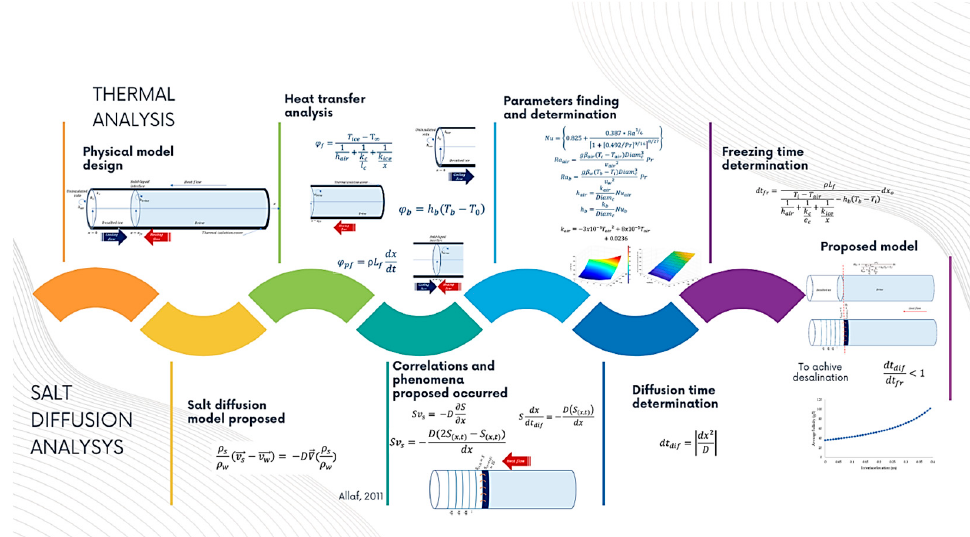
Figure 5. Schematic flow diagram for the conception of the F/M desalination model.